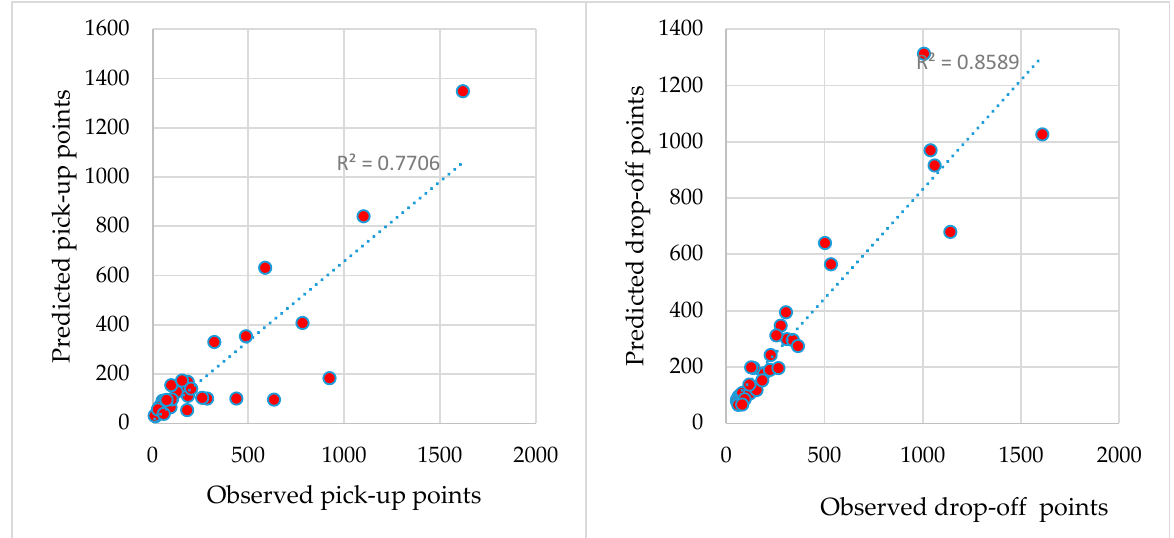
Figure 9. Predicted pick-up and drop-off points compared to observed.